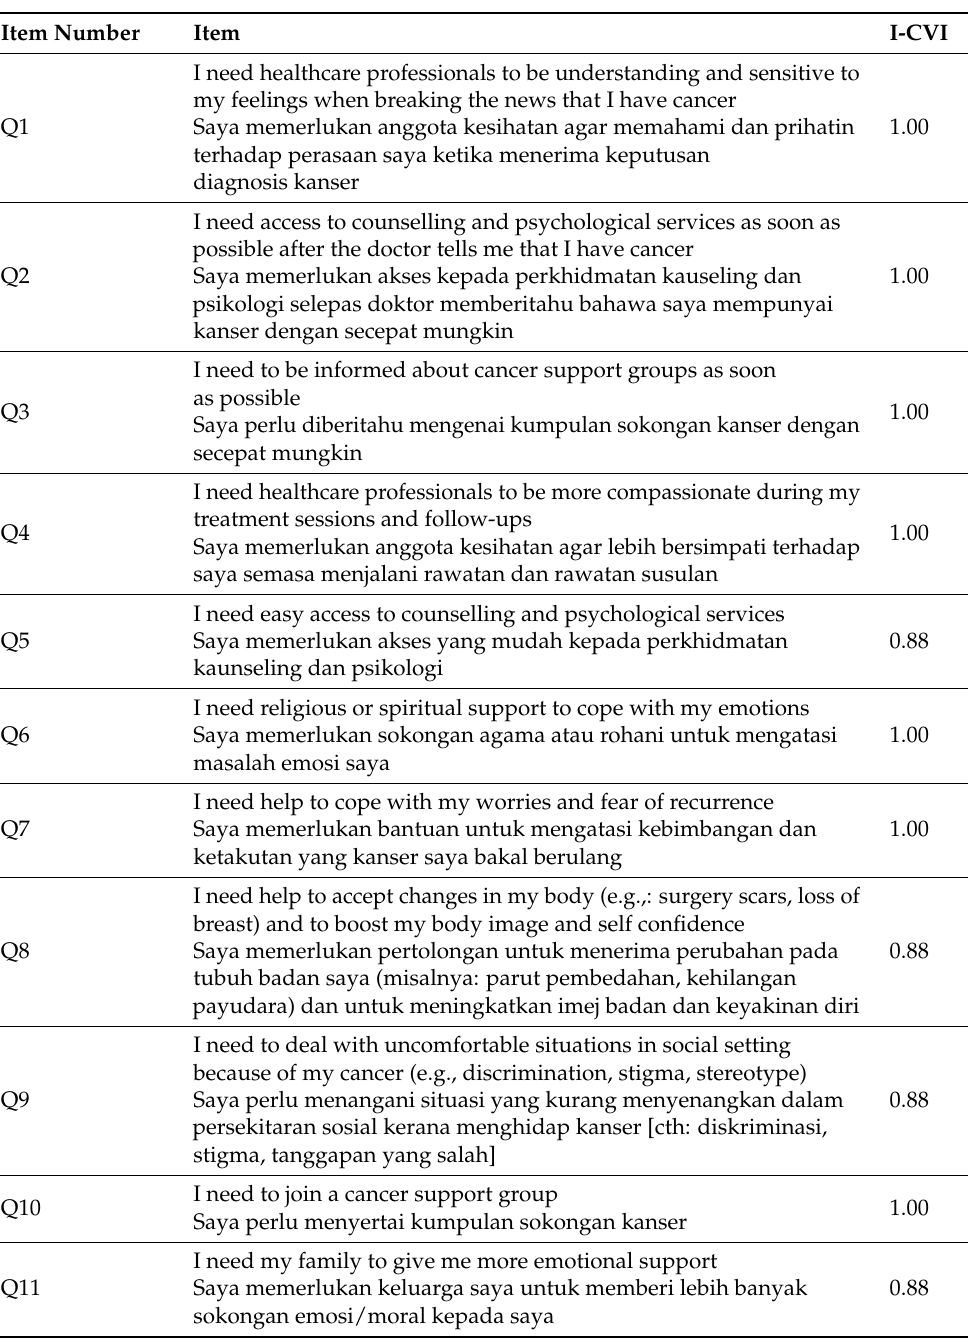
Table 1. Content validation of the needs assessment tool for breast cancer